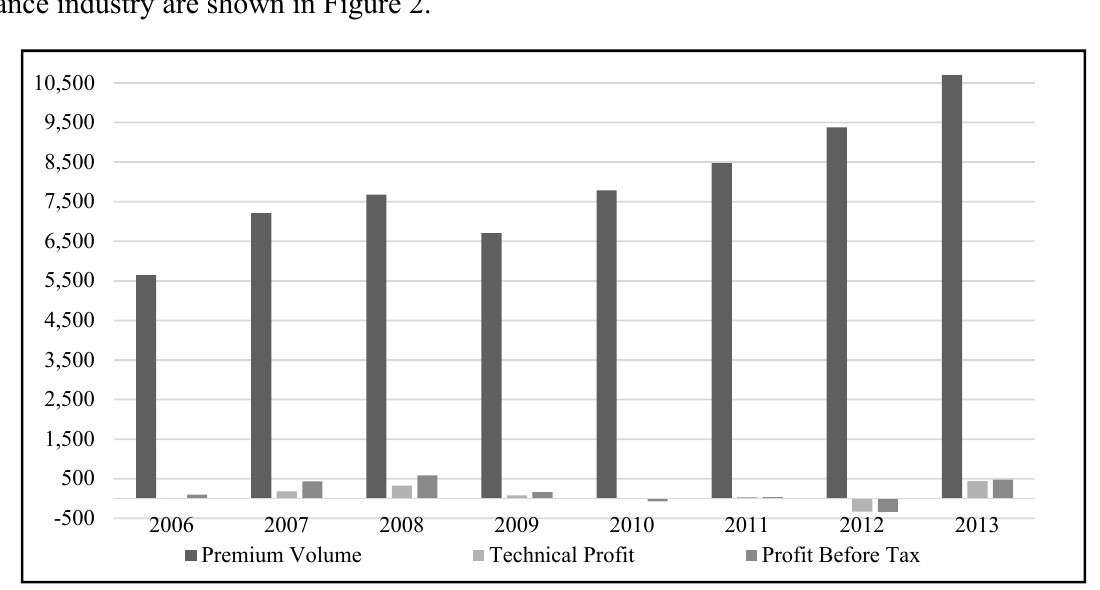
Figure 2. Financial performance of the non-life insurance industry in Turkey for the period of 2006–2013 (in millions of USD). Source: own graphic based on the Undersecretariat of Treasury’s Annual Reports about Insurance and Private Pension Activities (the Undersecretariat of Treasury